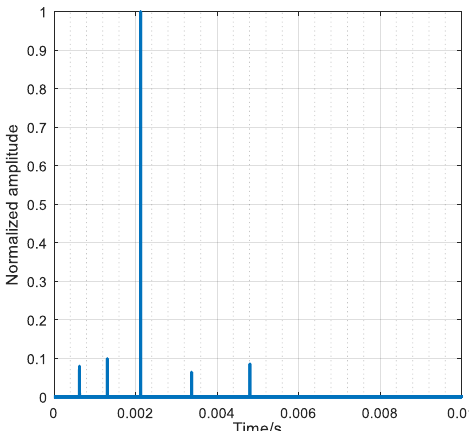
Figure 12. The estimated channel transfer functions between the target and element 2.